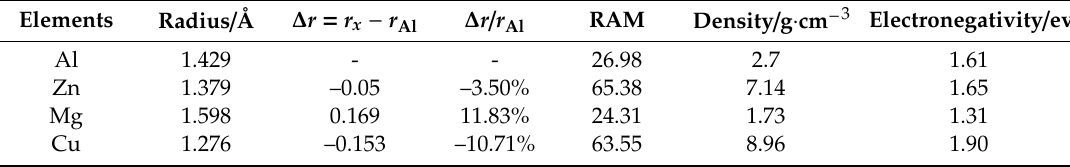
Table 3. Physical parameters of each alloying element in 7000 series aluminum alloy. Elements